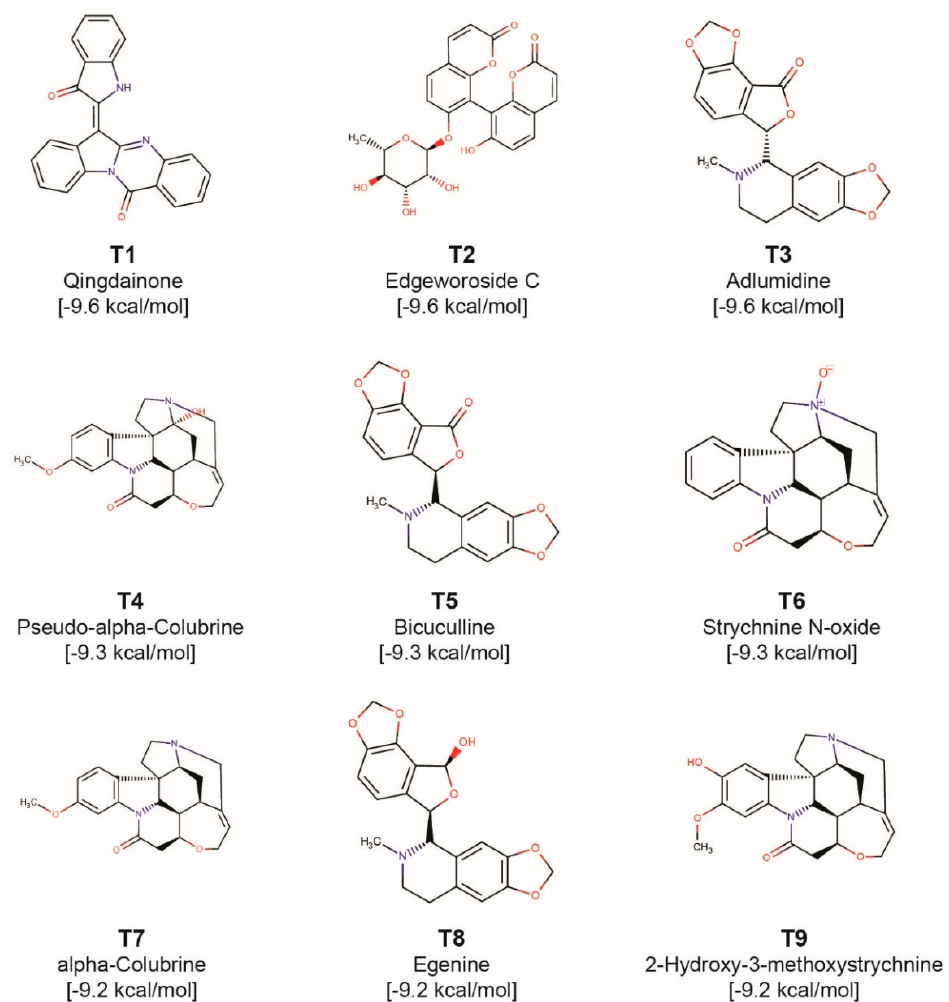
Figure 4. Molecular structures of the top 9 phytochemical inhibitors (compounds T1–T9 ) of TMPRSS2. For each inhibitor, the figure shows the 2D structure, common name and docked binding energy of the ligand with TMPRSS2.